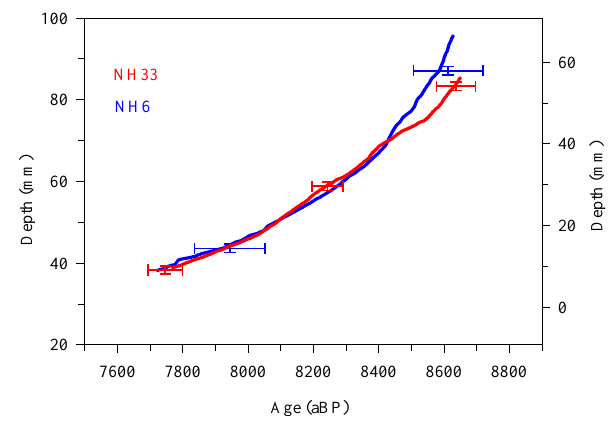
Fig. 3. Independent assessment of the annual growth band-counting chronologies for the two stalagmites using five 230 Th dates. Uncer- tainties of dating ( ± 48 to ± 106yr) and sampling position ( ± 0 . 5 to ± 1mm) are represented by horizontal and vertical bar,